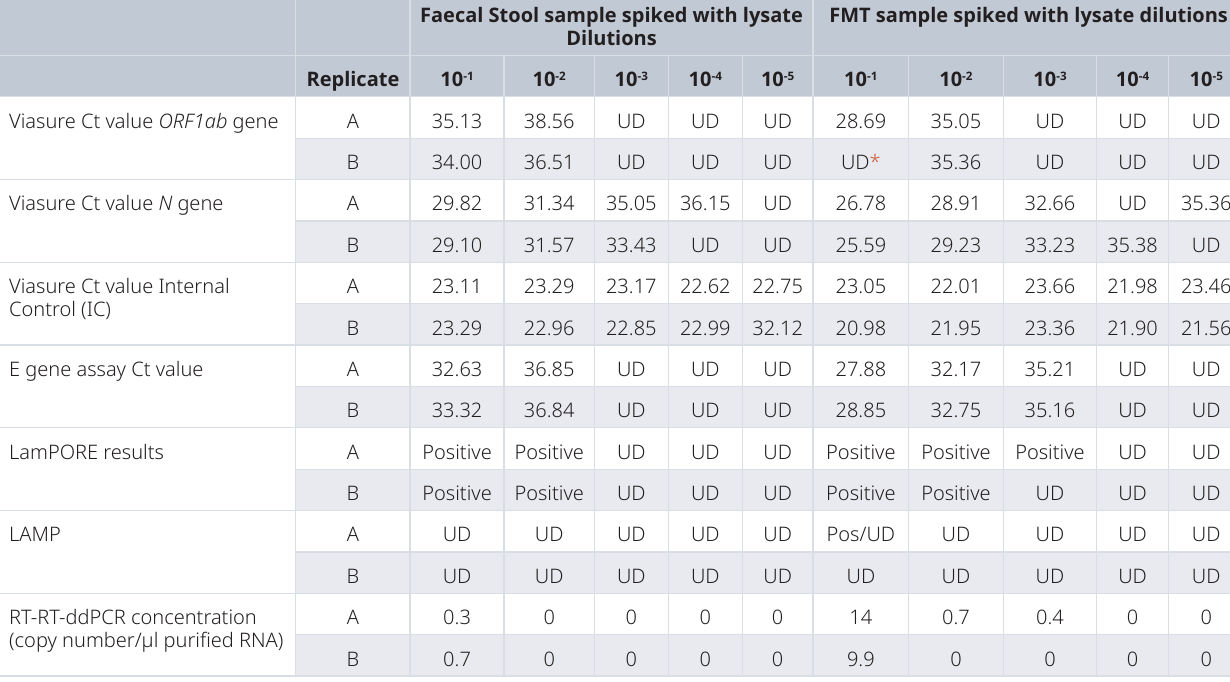
Table 2. Amplification results of dilutions of cell lysate spiked into faecal and FMT samples.